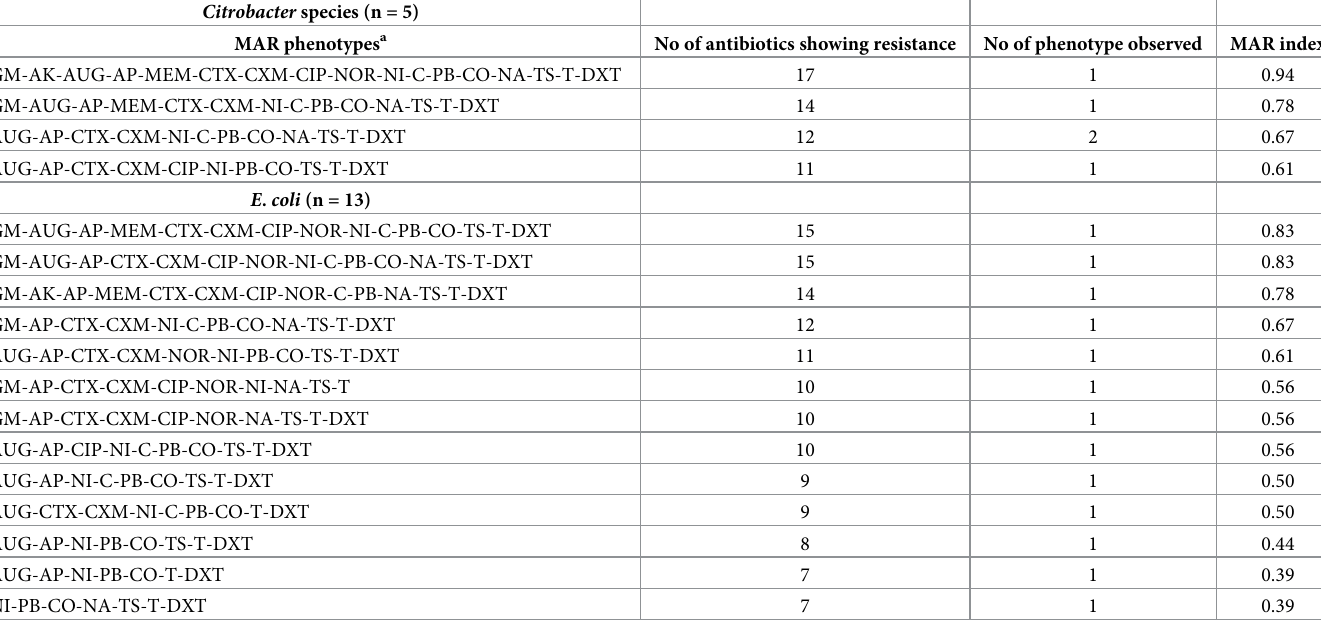
a represents antibiotics code which are explained in Fig 4